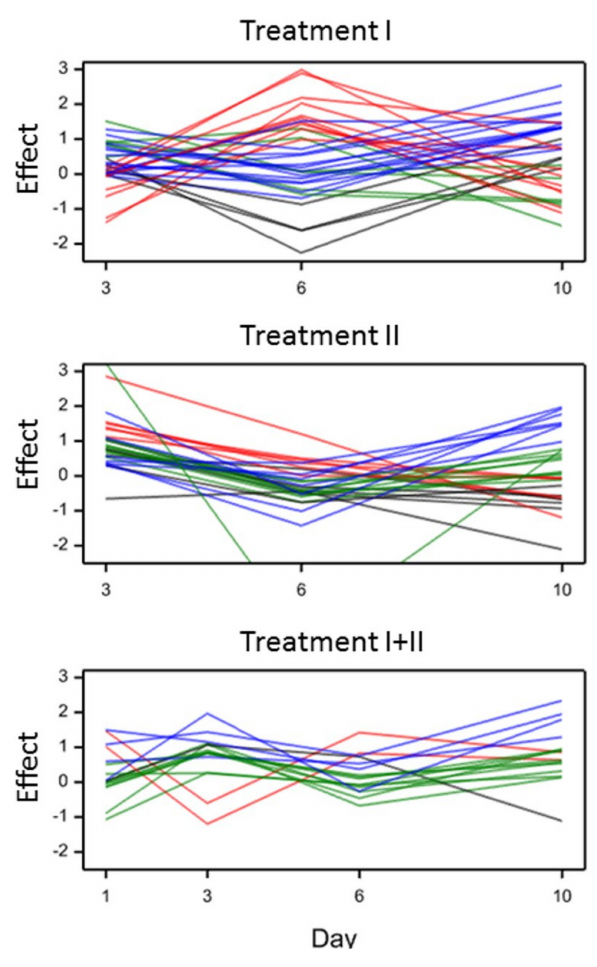
Figure 2. Time profiles of e ff ects of water deficiency (averaged over varieties) for metabolites characterized by e ff ects significantly modified by time (treatment duration (TD) e ff ects); clusters of metabolites with di ff erent profiles: A—black, B—red, C—green,